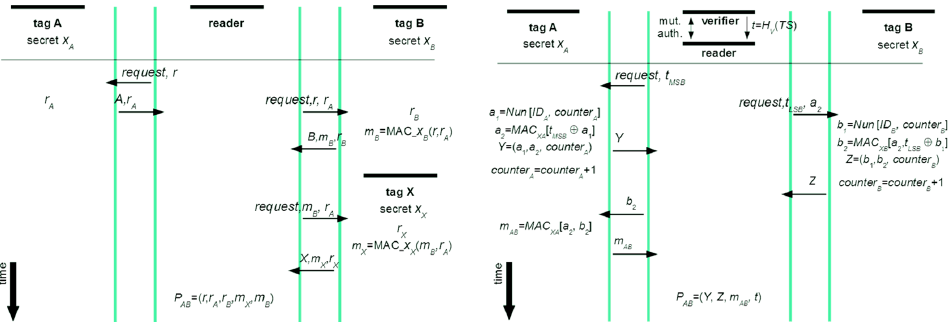
Figure 3. An attack on Piramuthu’s protocol by Peris-Lopez et al. ( Left ) and Clumping proof scheme ( Right ).